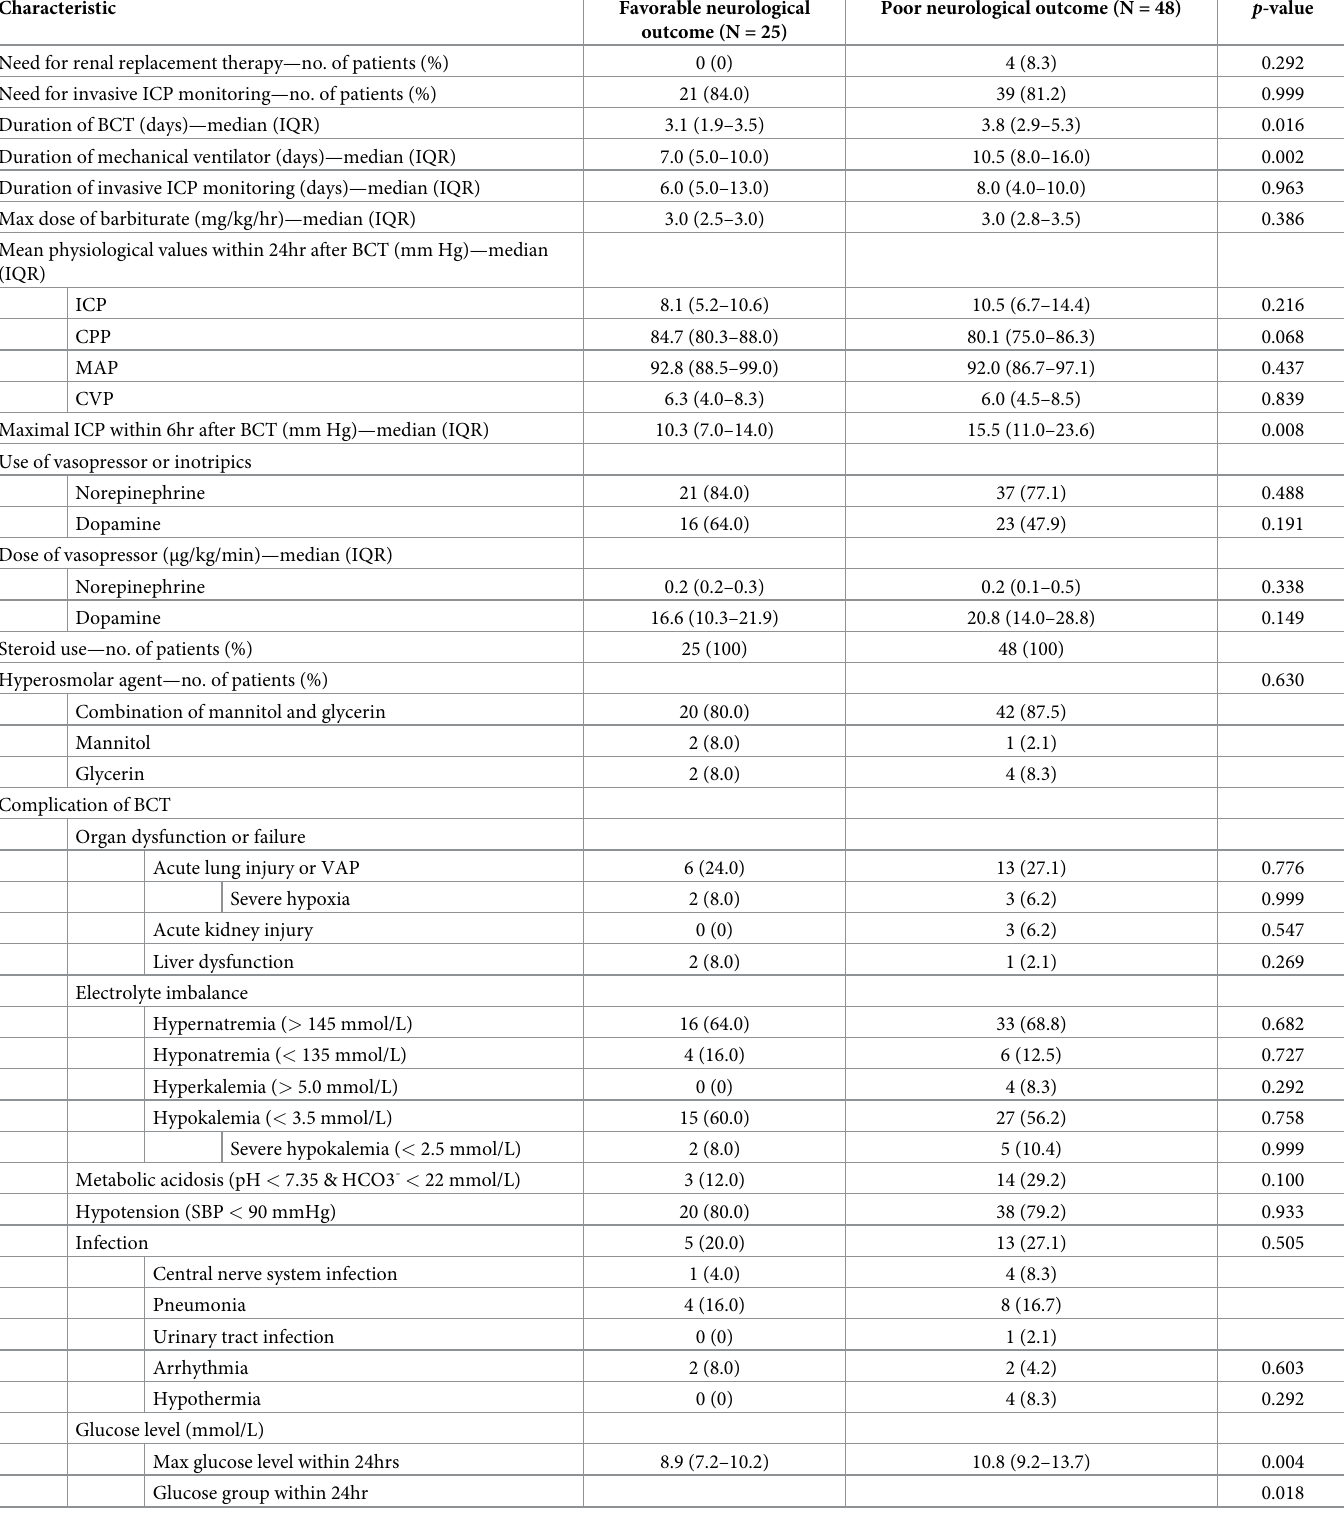
Table 2. Clinical characteristics and